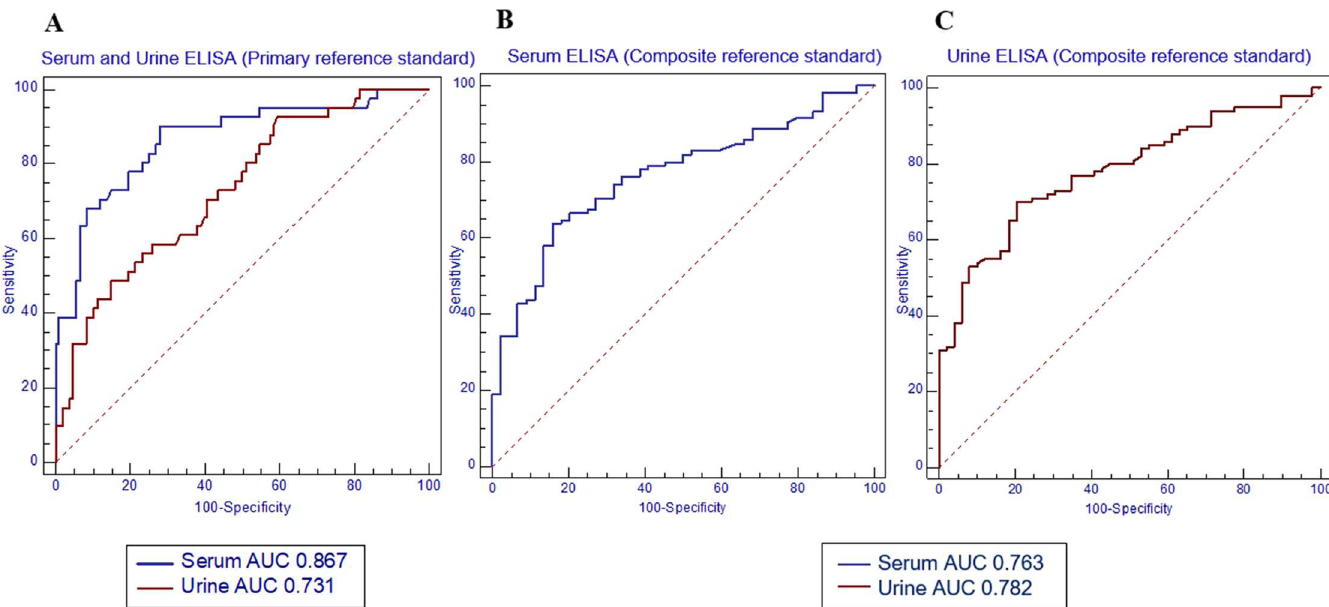
Fig 4. The comparison of the ROC curves. The ROC curve illustrates the comparison between the diagnostic performance of antibody detection using a urine assay and a serum assay. The model used to construct the ROC curve was modeled to include negative controls (strongyloidiasis negative and other infections) and individuals who were infected with strongyloidiasis. A; Primary reference standard for serum and urine ELISA, B; Composite reference standard for serum ELISA, C; Composite reference standard for urine ELISA.